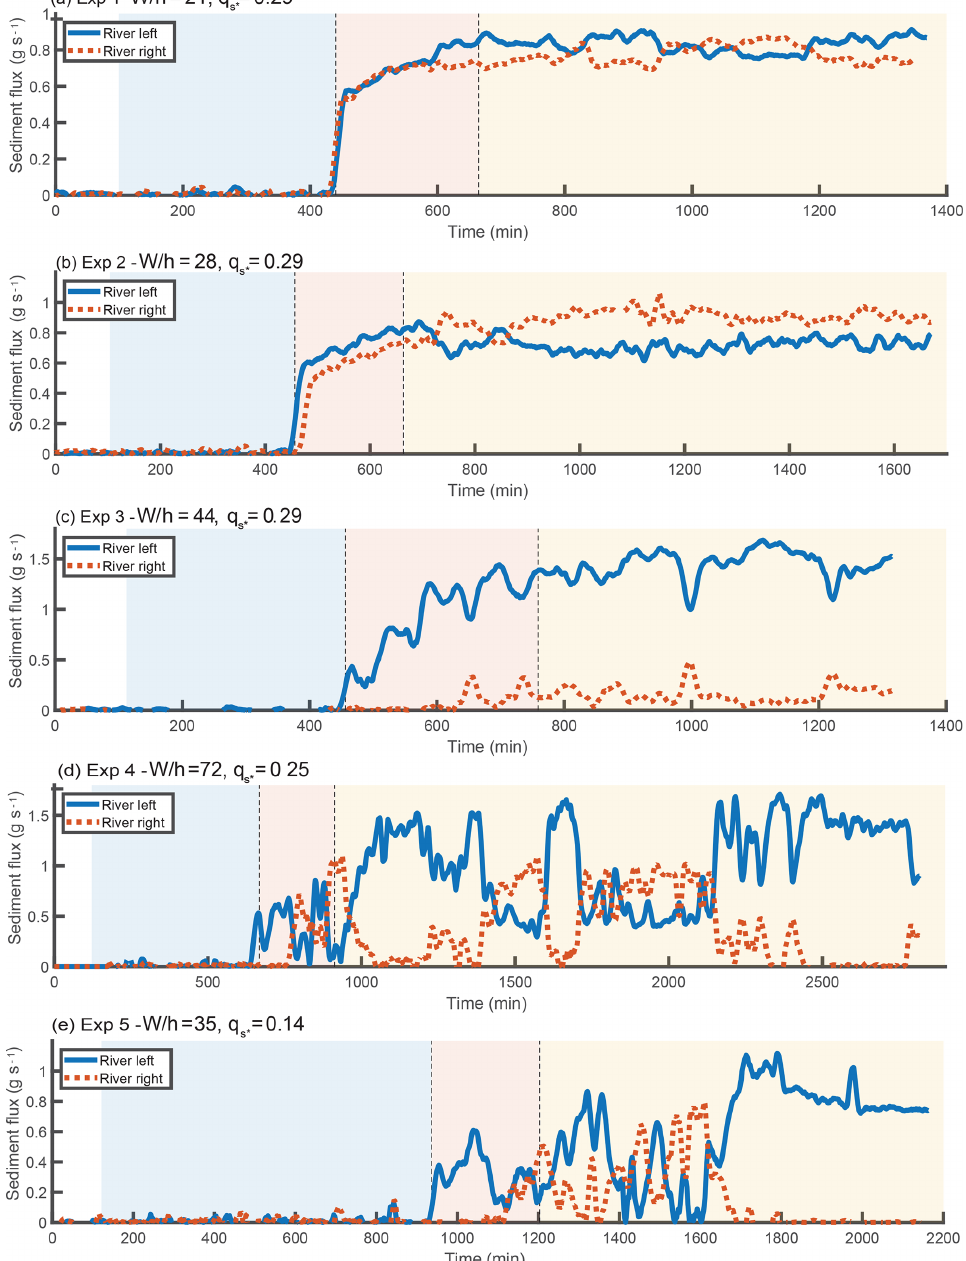
Figure 4. Time series of sediment flux exiting each branch. The data have been smoothed using a double moving average with a window of 20min. Background colors represent the progradational, transitional, and bypass phases of each experiment. During the progradation portion of the experiments, no sediment leaves the flume. The outgoing sediment flux gradually increases during the transitional phase and reaches a statistical steady state during the bypass